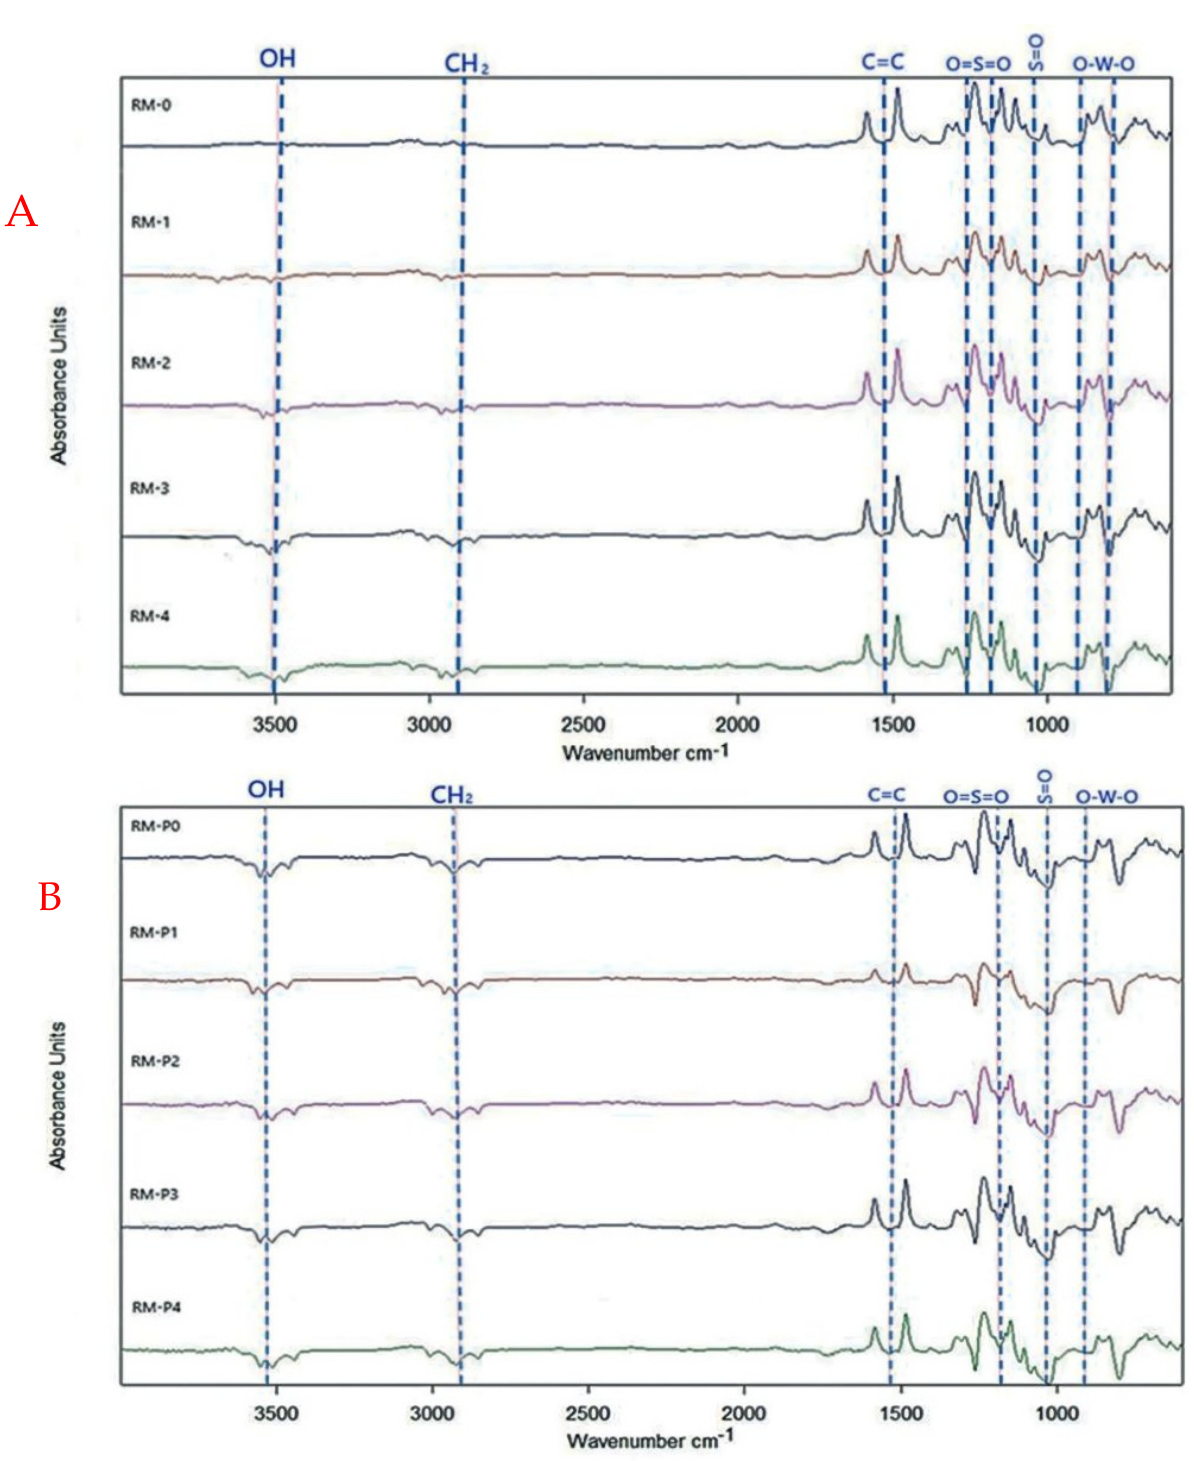
Figure 10. The infrared spectrum of ( A ) PPSU pure and composite membrane, ( B ) PPSU/PVP composite membranes.